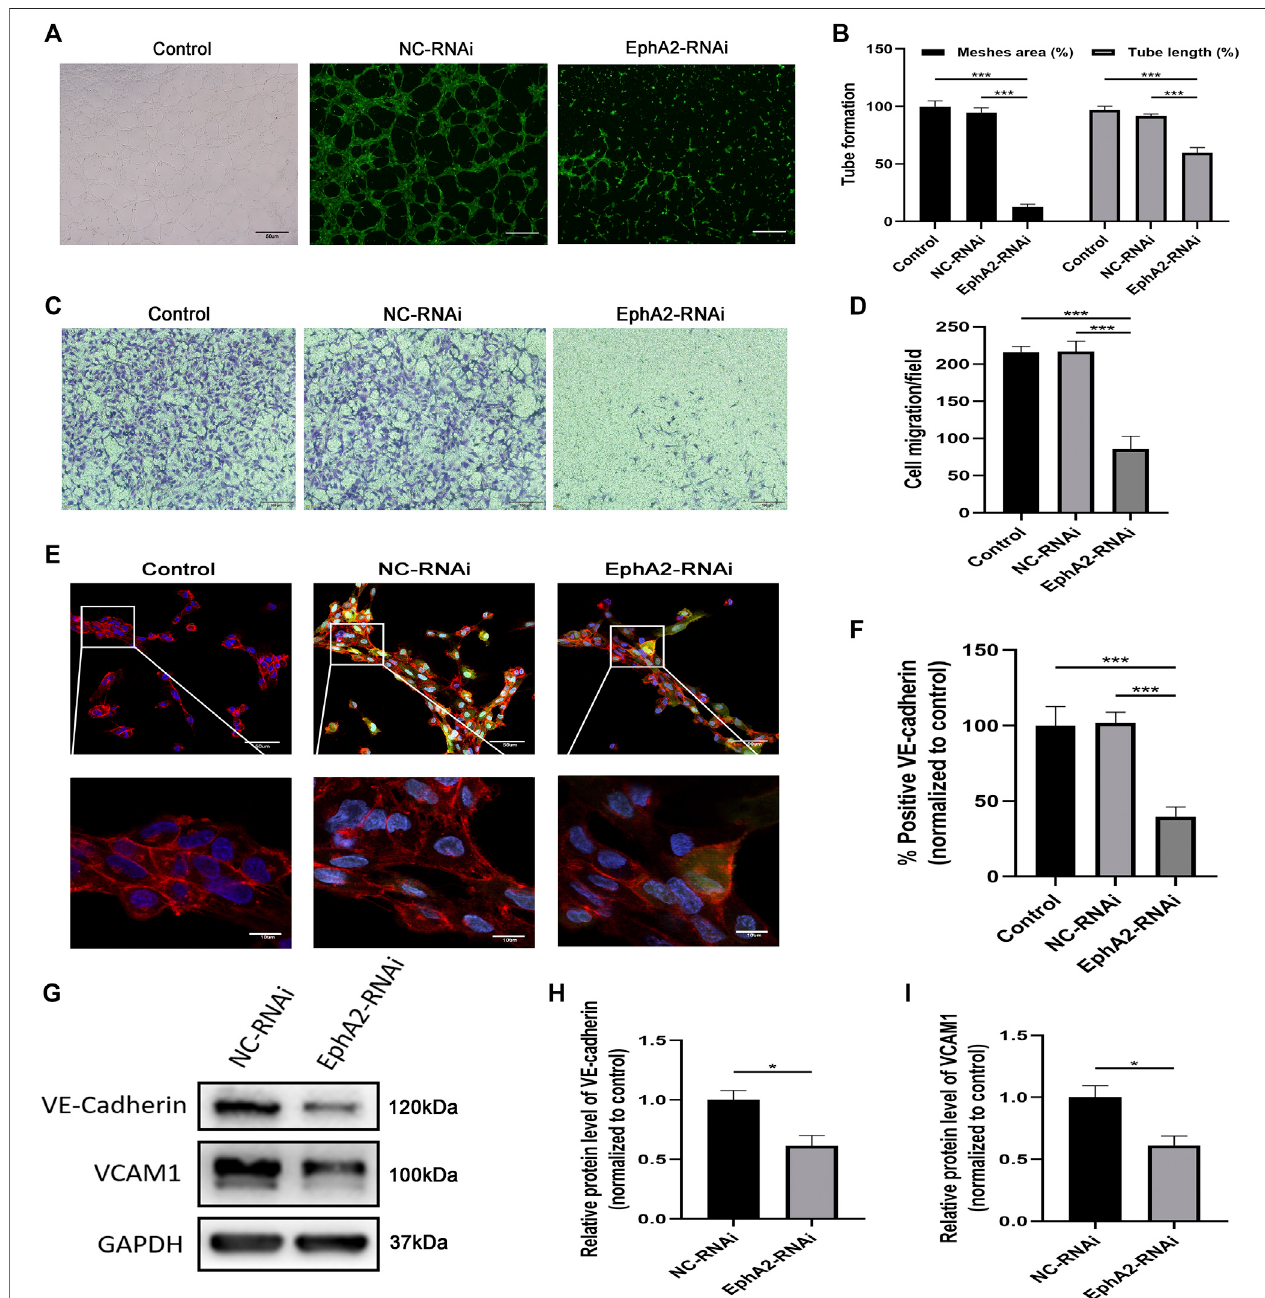
FIGURE 3 | EphA2 depletion suppressed HUVECs migration and angiogenesis. (A,B) Results of tube formation assay of EphA2 knockdown cells by lentivirus infection compared with NC-RNAi cells and wild-type control. Scale bar, 50 μ m (C,D) The cell migration was evaluated by the Transwell cell migration assay between groups mentioned above. Scale bar, 100 μ m. (E) The distribution of VE-cadherin (red) in the cell membrane and DAPI (blue) was observed by immuno fl uorescence confocal microscopy in EphA2 knockdown HUVECs (GFP-labeled, green). Scale bar, 50 and 10 μ m. (F) Statistical results of fl uorescence intensity of VE-cadherin (normalized to control) in HUVECs. Fluorescence intensity was calculated with six randomly selected cells from the visual fi eld. (G – I) The expression of VE-cadherin and VCAM1weredetectedbyWesternblottingassayinEphA2knockdowncellsandNC-RNAicells.Dataarepresentedasmeans ± SEM(* p < 0.05,** p < 0.01,*** p < 0.001 vs. vehicle control, ANOVA, n (cid:1) 3 or